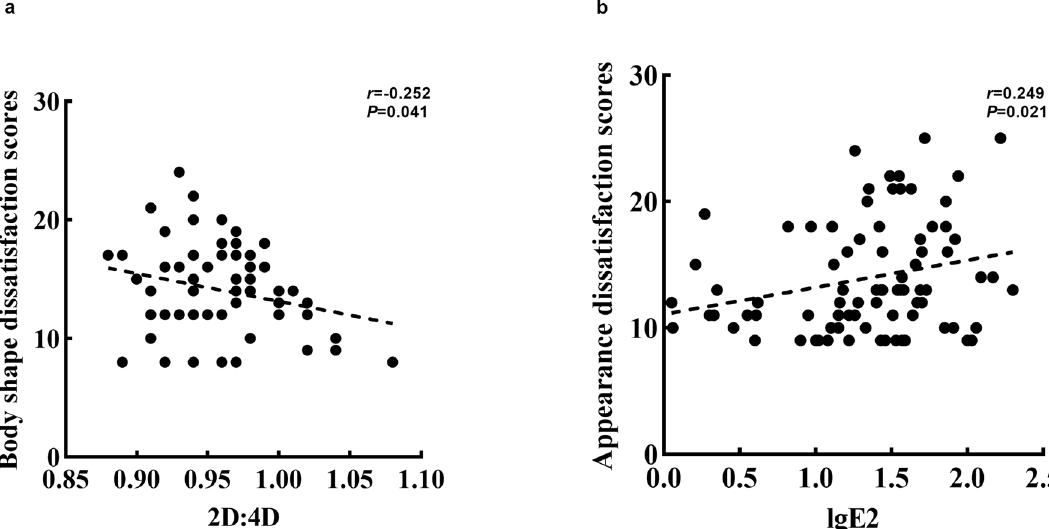
Figure 4. The associations between digit ratio (2D:4D) and body image dissatisfaction among girls with different puberty developmental stages. ( a ) The association between 2D:4D and Body shape dissatisfaction scores among girls with breast development < Tanner stage II; ( b ) the association between lgE2 and Appearance dissatisfaction scores among girls with breast development ≥ Tanner stage II and